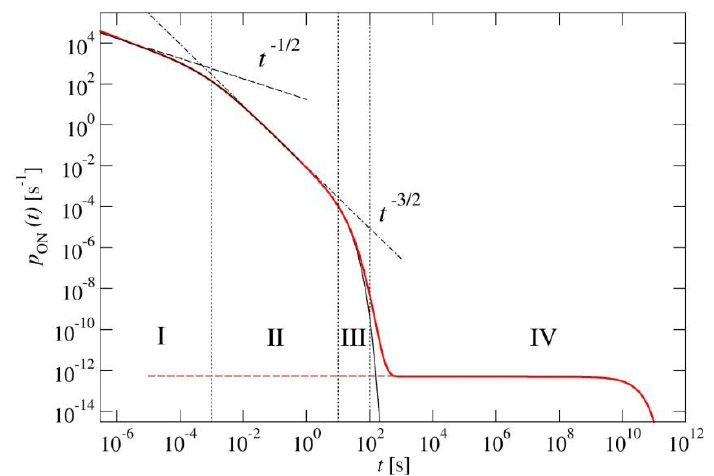
Fig. 1. The ON time distribution function within the DCET model (thick red line), the first interval power law (black dashed line), the second interval power law (black dashed-dotted line), the Tang- Marcus approximation (thin black line) and the long-time exponential asymptotic (dashed red